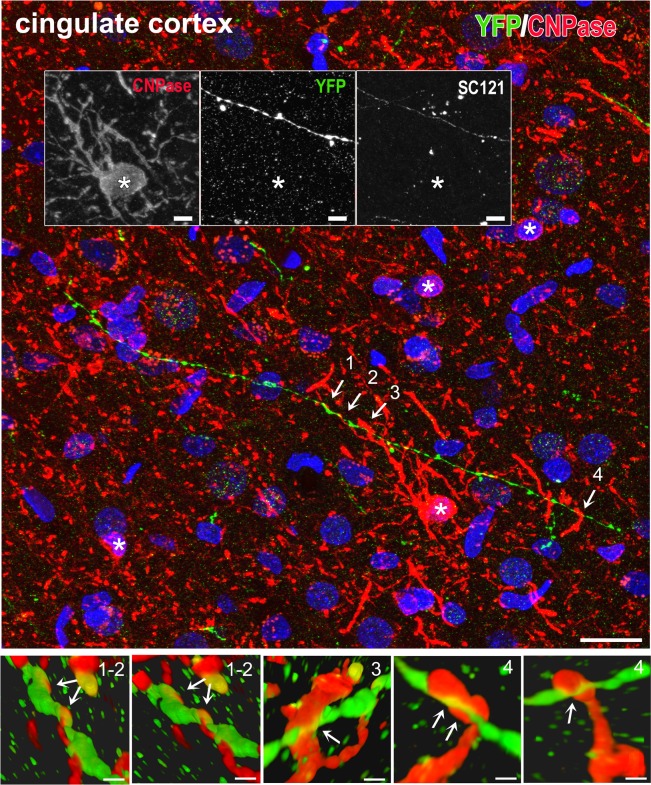
An example of ensheathing-type contacts made between a transplant-derived axon and several host-derived (rat) oligodendrocytic processes in host cingulate cortex.Maximum projection confocal image was captured from a section triply immunostained for YFP for transplant-derived axons (green), CNPase for oligodendrocytes (red) and SC121 for transplant-derived cells (white). (Top panel). Although four oligodendrocyte cell bodies are identified (asterisks), it appears that many of the contacts are made by the centrally located cell. None of the red oligodendrocyte profiles was double labeled with SC121, indication that they were of host origin (the lack of SC121 immunostaining of the central profile is shown in inset, against the SC121 immunoreactivity of the human axon). For the sake of conveying a sharper color, white was omitted from the panel. Examples of ensheathing contacts are indicated with numbers 1–4. (Bottom panels). Here we performed 3D reconstructions of ensheathing profiles 1–4 to show the detailed configuration of the human axon and the host oligodendrocytic processes enveloping it. Ensheathing profile 3 has unusual morphology, but this may be related to the immaturity of the process. Scale bars: Top panel, 20 μm; insets, 5μm; bottom panels, 1μm.